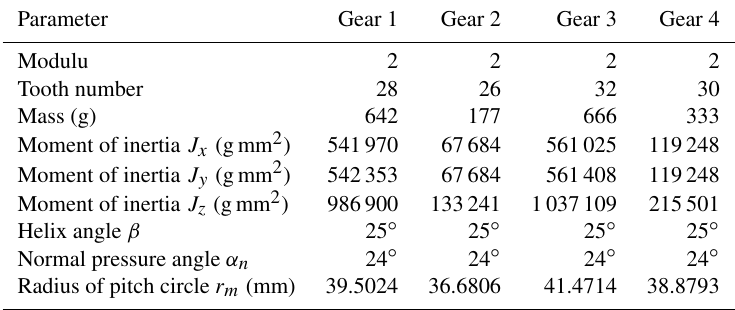
the material of double circular arc spiral bevel gear is set as structural steel, elastic modulus E is 206 GPa, Poisson’s ratio is 0.29, mass density is 7850 kg m − 3 . The mesh models of double circular arc spiral bevel gears 1 and 2 are shown in Fig. 7. By setting the order of modal solution and solving the modal of bevel gears, the vibration mode diagrams of dou- ble circular arc spiral bevel gears can be obtained. Taking the vibration mode diagram of internal bevel gear 1 as the ex- ample, the 1st and 2nd order modes are torsional vibration, and the end face of bevel gear oscillates back and forth along the radial straight line passing through the axis, as shown in Fig. 8. The 3rd and 4th order modes of the internal bevel gear 1 are folding vibration. The bevel gear 1 appears as V-shaped along the axis, and the regular polygon on the end face, as shown in Fig. 9. The 5th order mode of the internal bevel gear 1 is an um- brella type vibration, and the bevel gear teeth are contracted into an umbrella shape along the large end in the axial direc- tion, as shown in Fig.